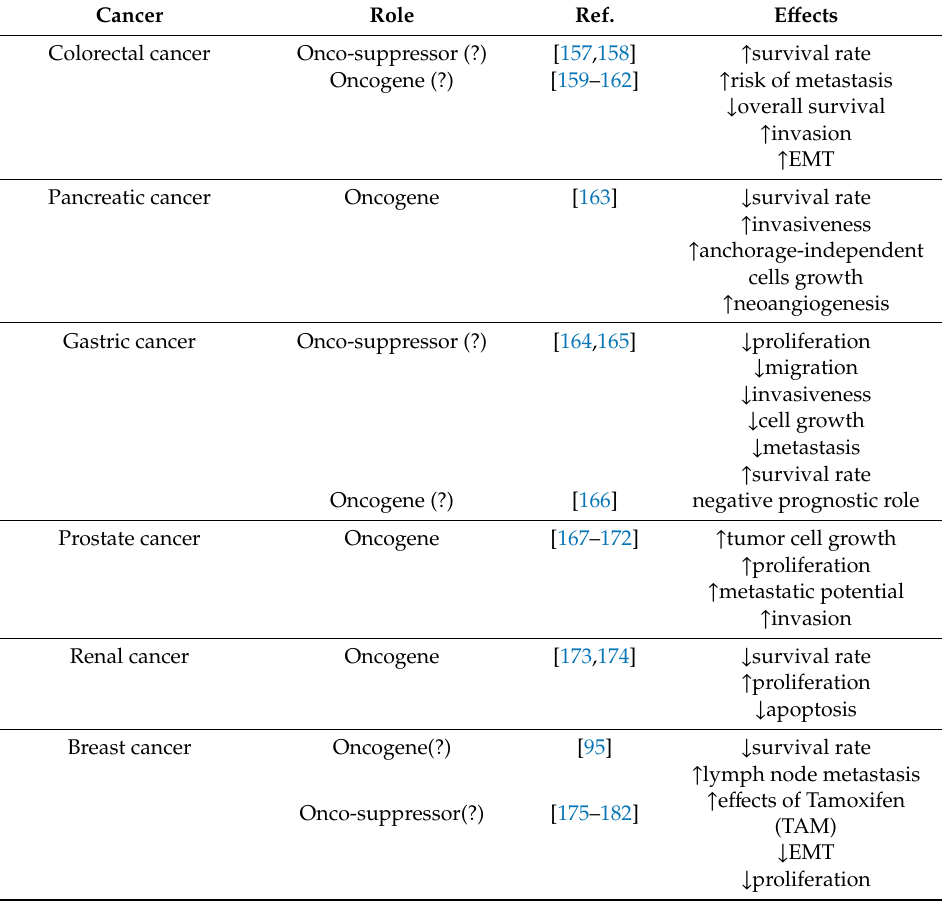
Table 1. COUP-TFII in cancer: role and molecular e ff